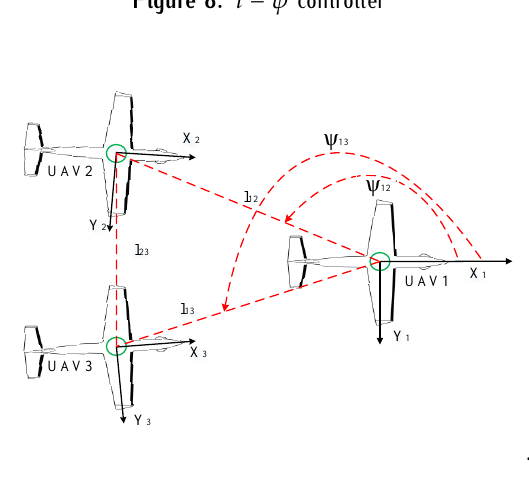
Figure 8. l − ψ controller